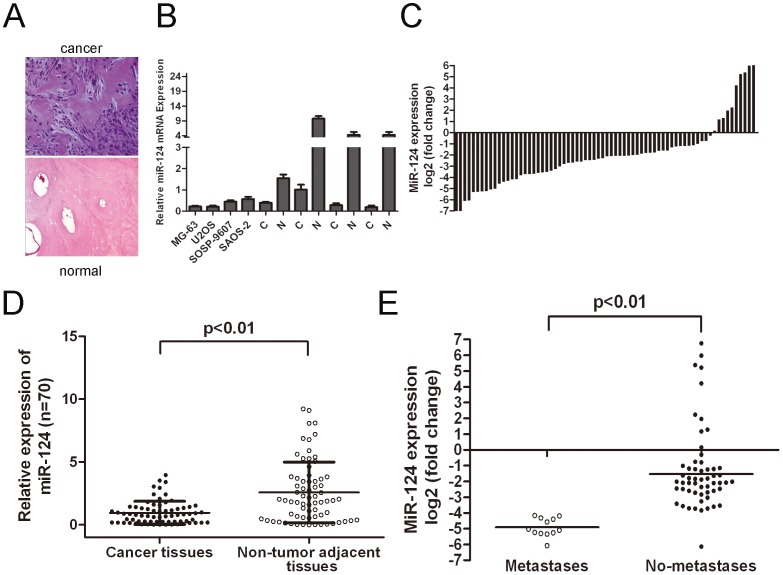
The expression of miR-124 in human osteosarcoma cell lines and tissues.(A) The patient who were diagnosed as in osteosarcoma in H&E staining (original magnification, ×100). (B) The expression of miR-124 in four human osteosarcoma cell lines (MG-63, U2OS, SOSP-9607, and SAOS-2) and four primary tissues (C) and adjacent non-neoplastic tissues (N) using real-time PCR. (C) miR-124 was detected in 70 osteosarcoma patients by real-time PCR. Data is presented as log 2 of fold change of GC tissues relative to non-tumor adjacent tissues. (D) The expression of miR-124 in the osteosarcoma tissues was lower than that in non-tumor adjacent tissues. P<0.01. (E) The expression of miR-124 in the metastases osteosarcoma tissues was lower than that in non- metastases tissues. Experiments were performed three times. All data uses t test and is shown as mean±SD.